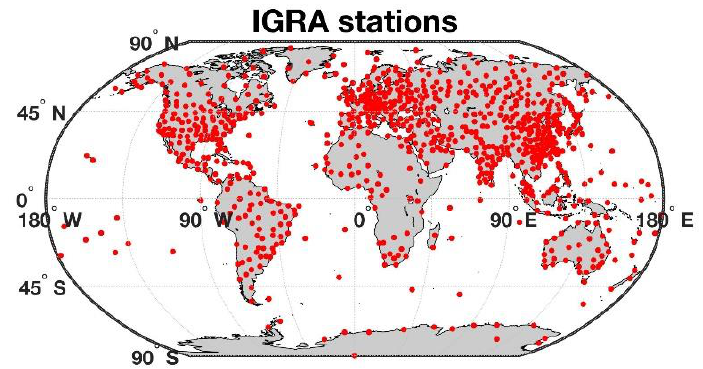
Figure 1. Location of the stations considered in the Integrated Global Radiosonde Archive (IGRA) database and involved in the training procedures.